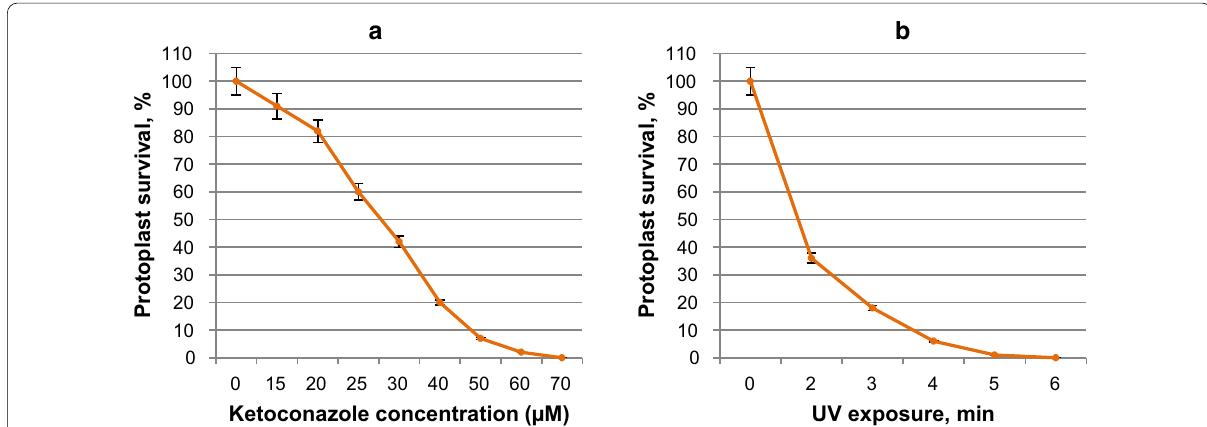
Fig. 6 Effect of ketoconazole concentration ( a ) and UV exposure ( b ) on survival of G. zeae protoplasts